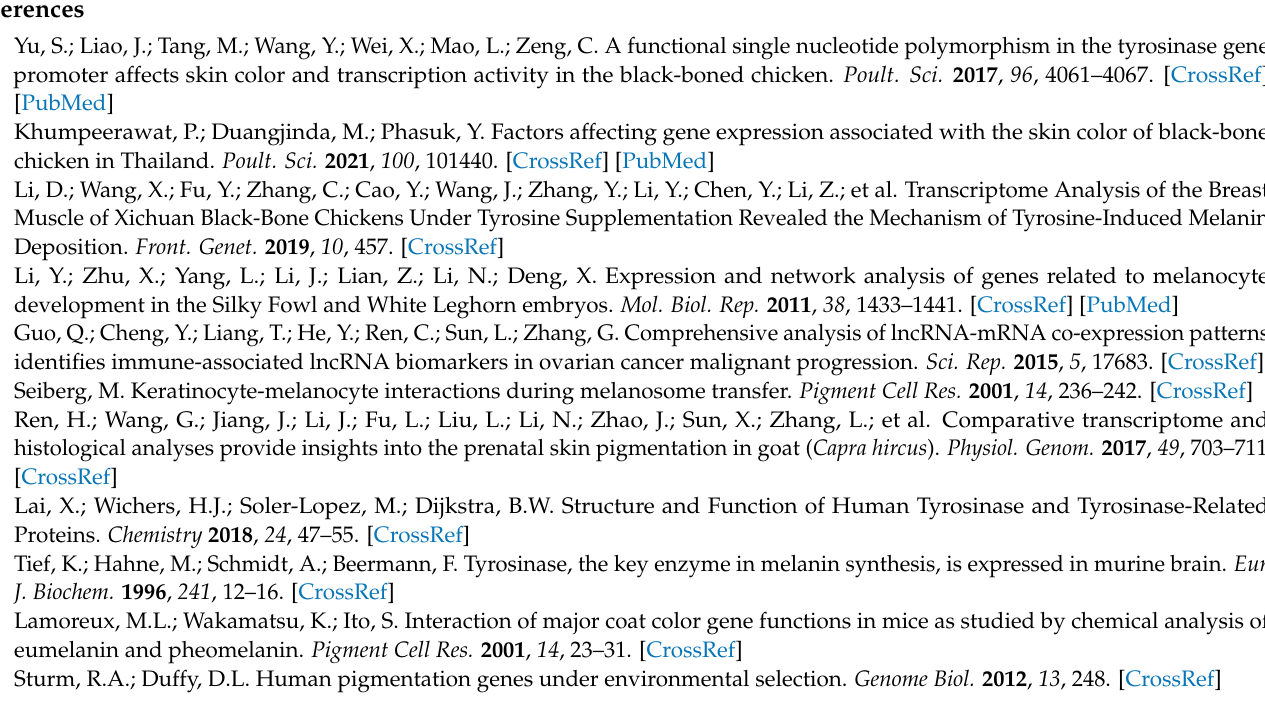
Xichuan black-bone chicken. Figure S2. The full-length LMEP sequences are listed in UCSC. Figure S3. The secondary structure of LMEP . Table S1. Primer sequence information. Table S2. Skin color characteristics of Xichuan black-bone chickens treated with YS and BS. The smaller that the numerical grade of the black color of the skin is, then the greater the yellow coloration will be. YS represents the yellow-skin group, and BS represents the black-skin group. Table S3. Characteristics of the reads from the six chicken skin libraries. YS represents the yellow-skin group, and BS represents the black-skin group. Mapped unique reads: reads that matched the reference genome in only one position. Mapping ratio: mapped reads/all reads. Table S4. Coding potential of LMEP . Table S5. lncLocator prediction